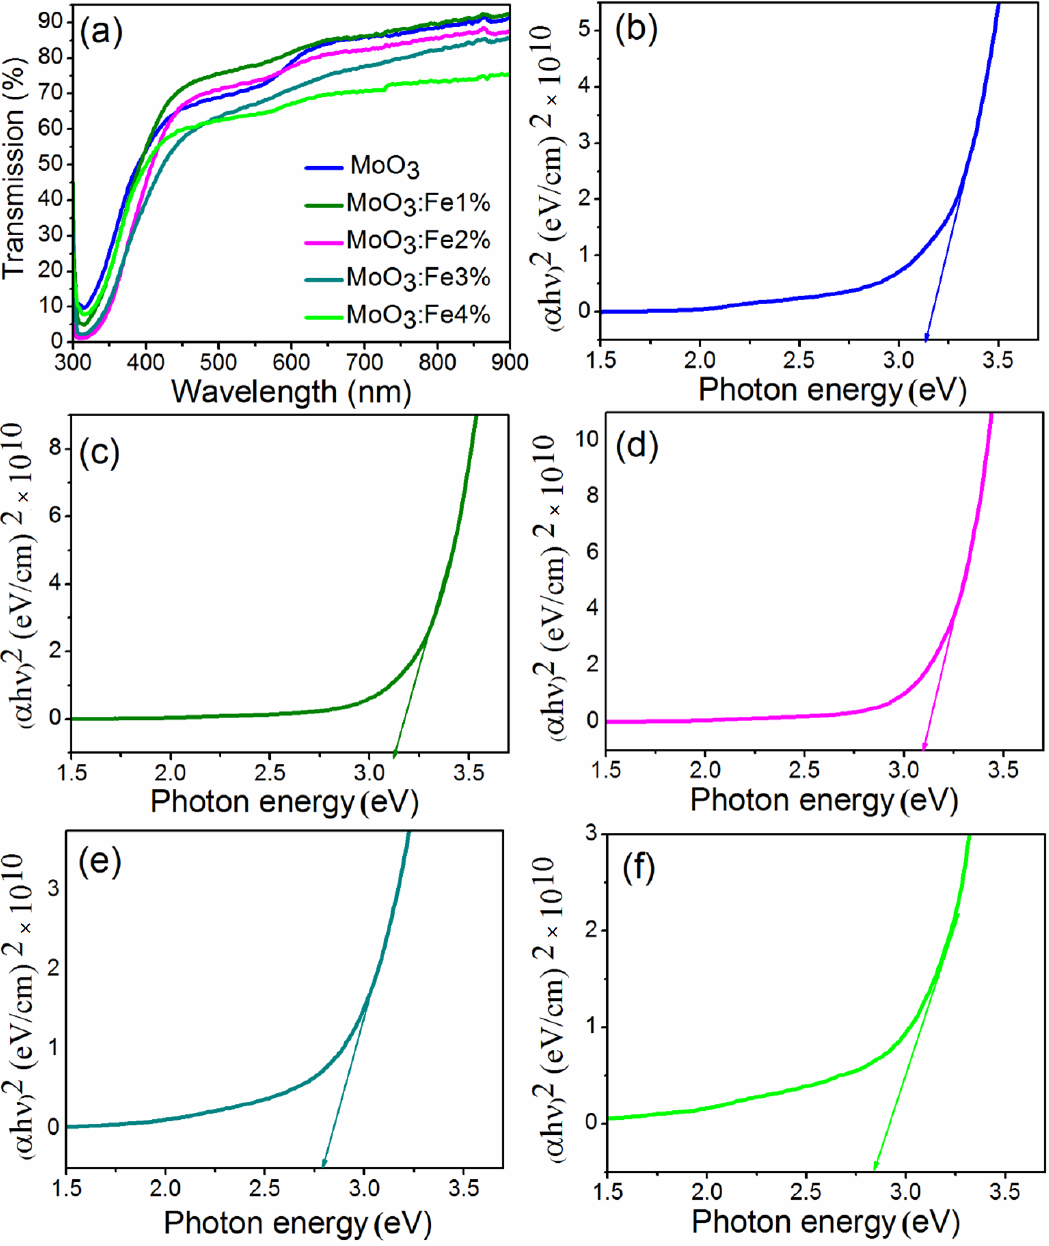
Figure 3. ( a ) Transmission spectra and Tauc’s plot of Fe doped MoO 3 thin films ( b ) 0%, ( c ) 1%, ( d ) 2% ( e ) 3%, ( f ) 4% of Fe